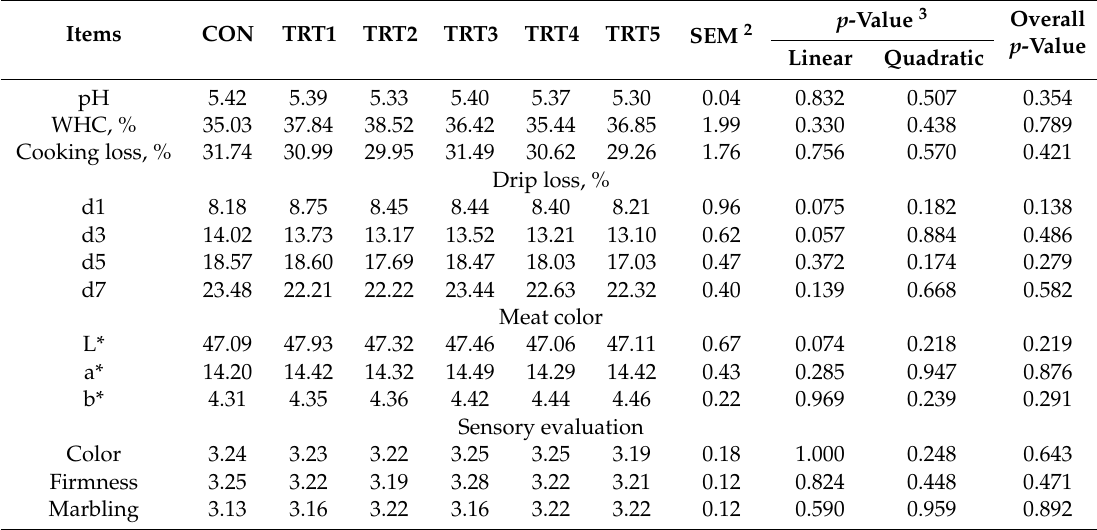
Table 7. The e ff ect of black pepper supplementation on meat quality of finishing pigs 1 .